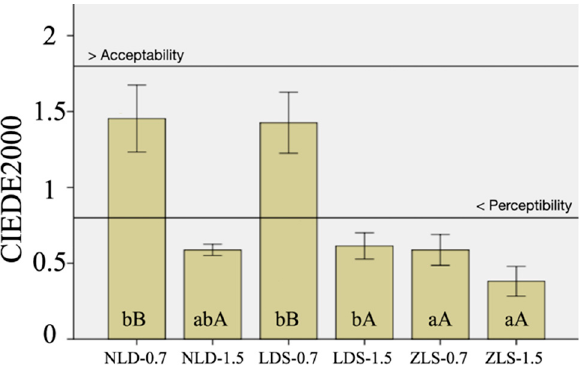
Figure 3. Means and 95% confidence limits of Δ E00 values for each material–thickness pair. Different lowercase letters indicate significant differences among materials with the same thickness, while uppercase letters indicate significant differences between different thicknesses of the same material ( p < 0.05). Horizontal lines represent the perceptibility threshold (0.8 units) and the acceptability threshold (1.8 units). Table 4. Comparison of p values for RTP values of clinically relevant pairs at the baseline and after coffee. Pairs